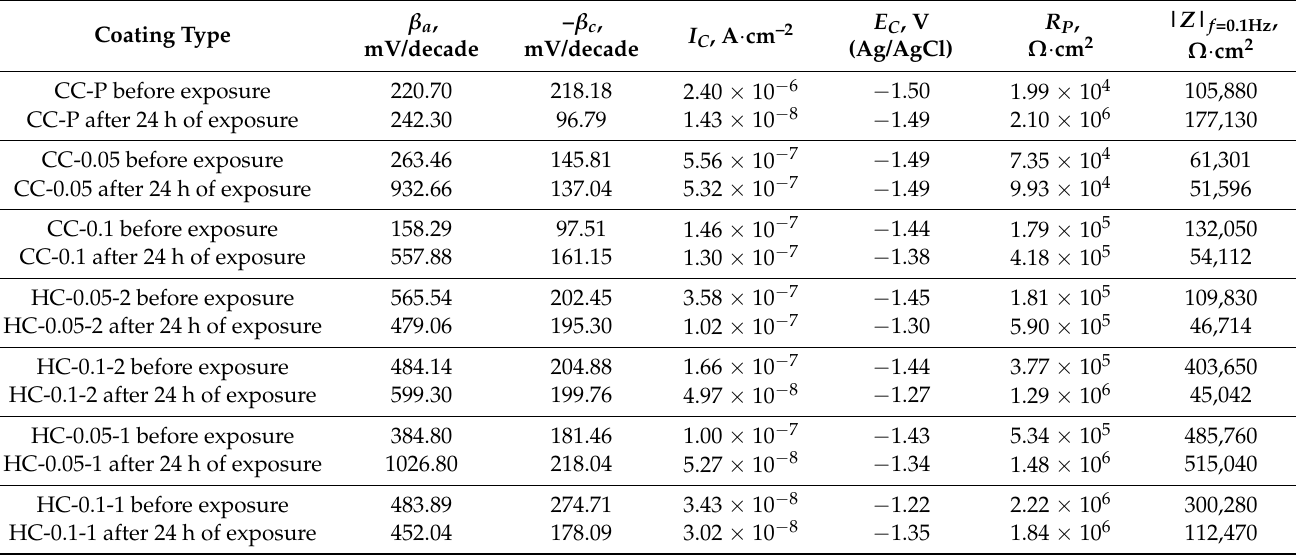
Table 3. Electrochemical parameters obtained by analyzing the polarization curves and impedance spectra before and after samples’ exposure to 0.9 wt.% NaCl solution for 24